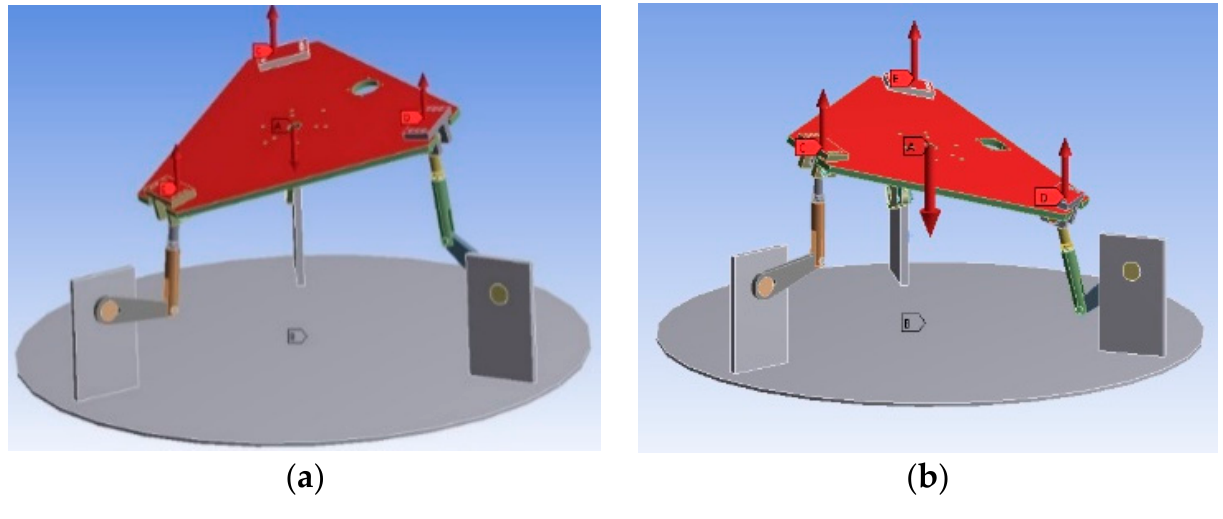
Figure 4. Stress analysis setting for ( a ) roll ( b ) pitch.